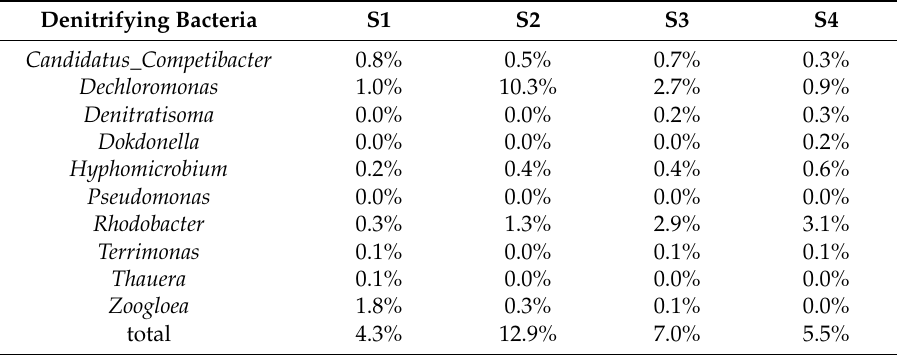
Table 3. The relative abundance of denitrifying bacteria at di ff erent C / N ratios